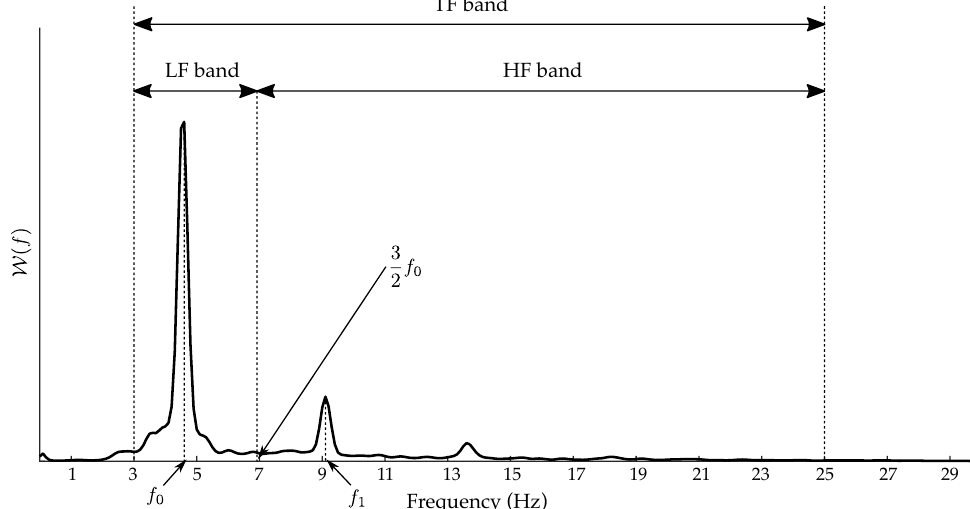
Figure 2. Spectral distribution of a common excerpt of f -waves divided into two frequency bands, i.e., low-frequency (LF) band and high-frequency (HF) band. Both form the total frequency (TF) band, ranging between 3 and 25